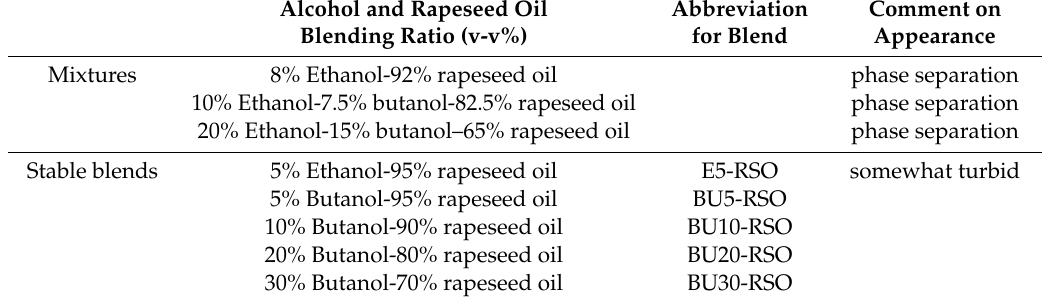
Table 1. Alcohol ‒ rapeseed oil mixtures tested for stability. Table 1. Alcohol-rapeseed oil mixtures tested for stability.